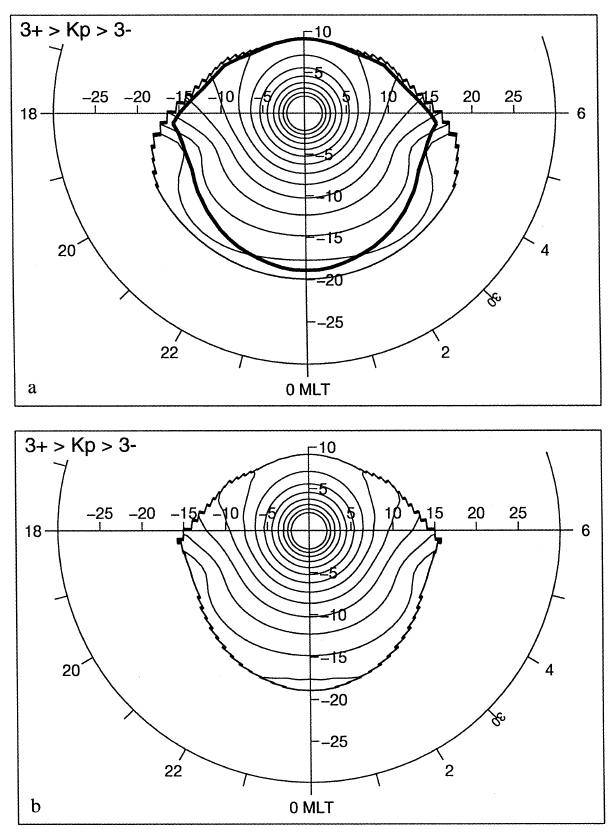
Fig. 4a, b. Contours of the B h component (in nT) in equatorial maps similar to Fig. 3a, b for 3 (cid:255) < Kp < 3 (cid:135) . The B h contours are represented as contours of the quantity Log( B h ). The contour interval is 0.25 and the closest contour to the Earth corresponds to 3.5. B h is given from the Tsyganenko (1987) model in a and computed from the Euler potentials illustrated in Fig. 3a in b . The bold line in a corresponds to the external boundary of the domain where the Euler potentials are computed